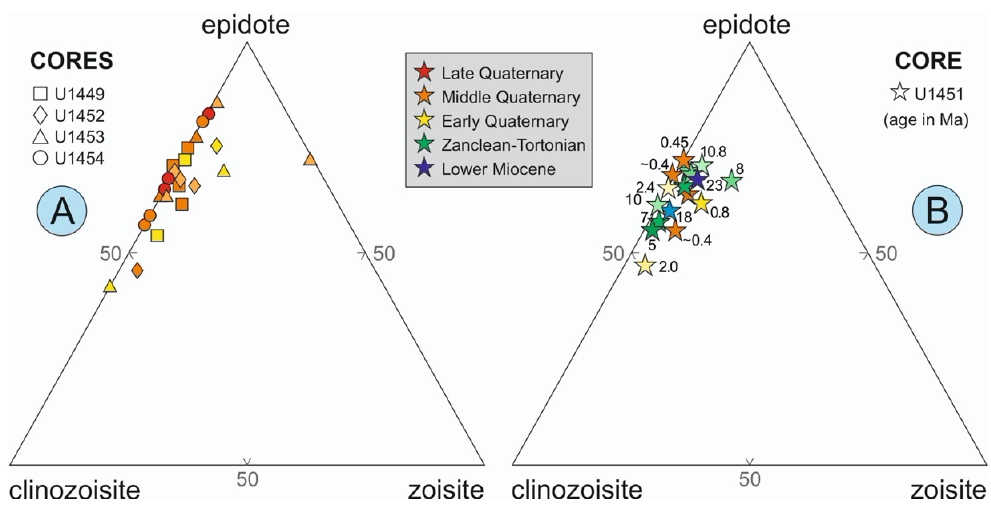
Figure 6. Relative abundance of epidote, clinozoisite, and zoisite in Bengal Fan turbidites. ( A ) Quaternary samples. ( B ) Miocene-Pleistocene samples from core U1451 (depositional ages are indicated) show no systematic variability with age and burial depth.